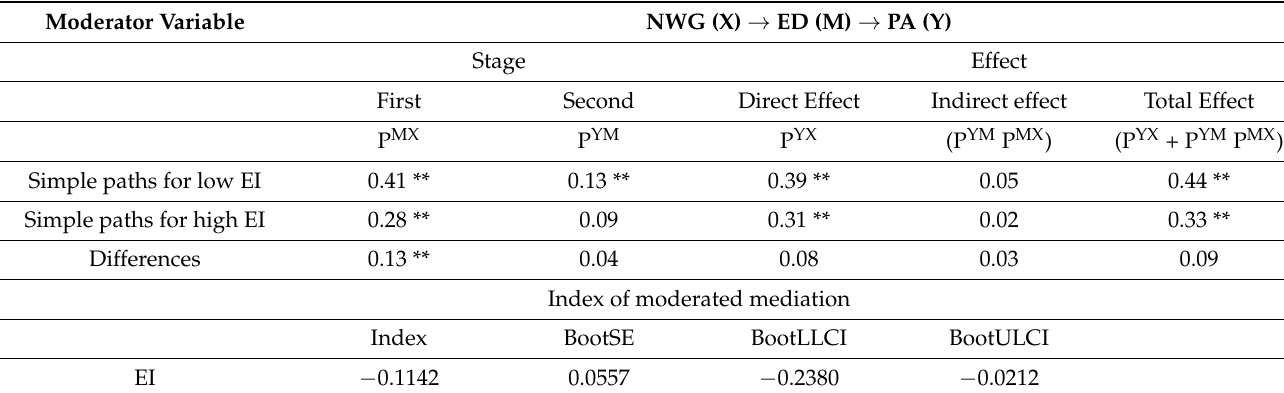
Table 5. Results of moderation mediation ( n = 277).